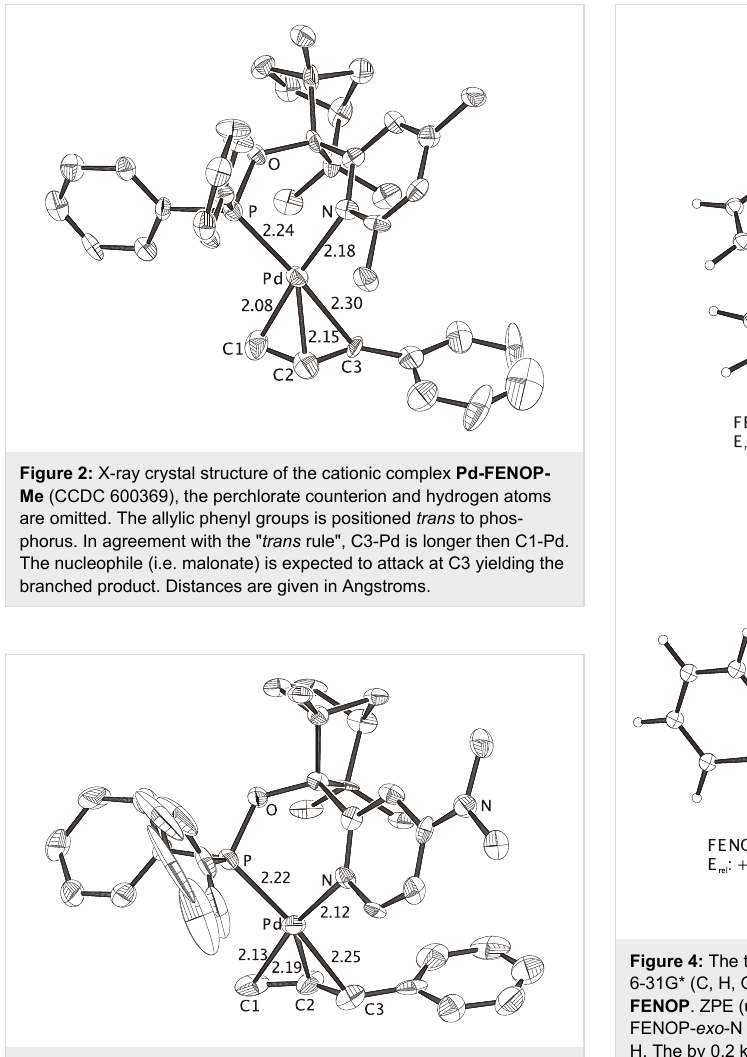
Figure 3: X-ray crystal structure of the cationic complex Pd-FENOP- NMe 2 (CCDC 600370), the perchlorate counterion and hydrogen atoms are omitted. The allylic phenyl groups is positioned trans to phosphorus. In agreement with the the " trans rule", C3-Pd is longer then C1-Pd. The nucleophile (i.e. malonate) is expected to attack at C3 yielding the branched product. The mean values of two independent complexes are given, distances are given in Angstroms.